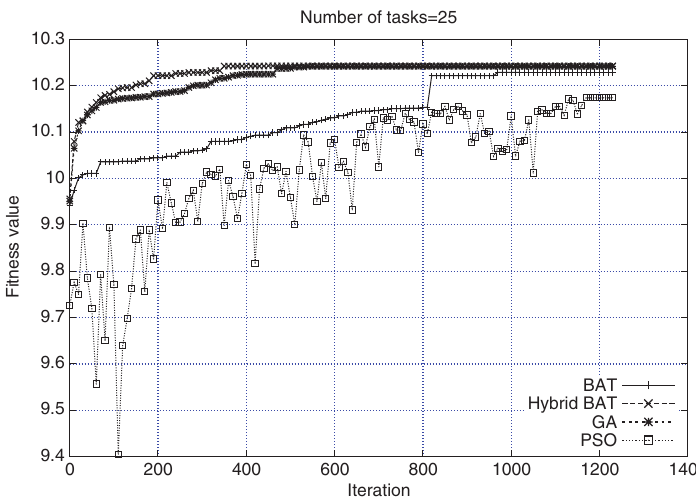
Figure 5: WS Composition – 25 tasks, 100 Candidate WSs.